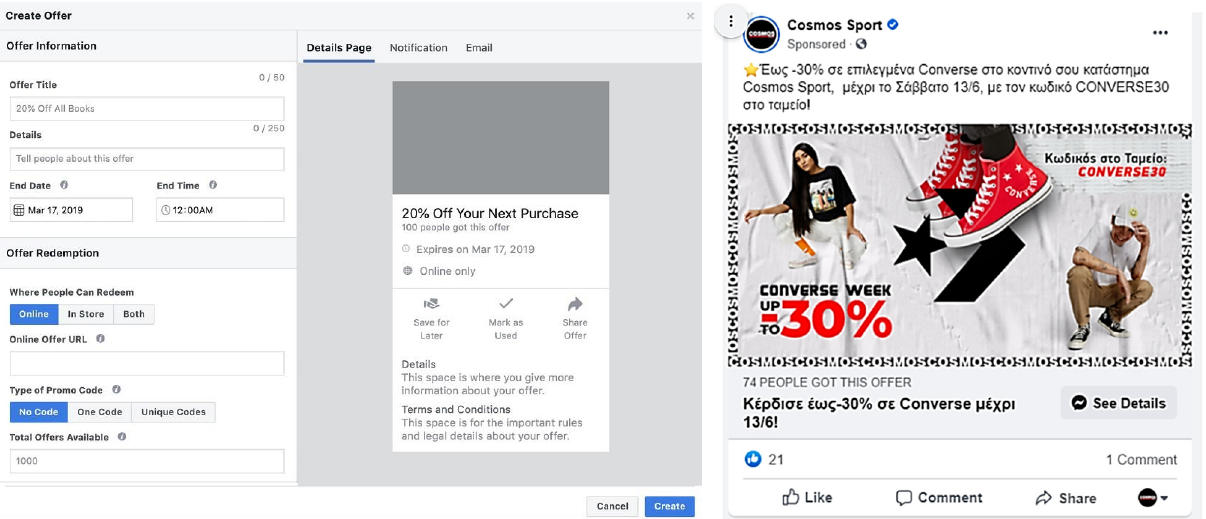
Figure 2. Facebook Offer Ads default redemption options ( left ) and a related coupon that was provided for the experiment ( right ).